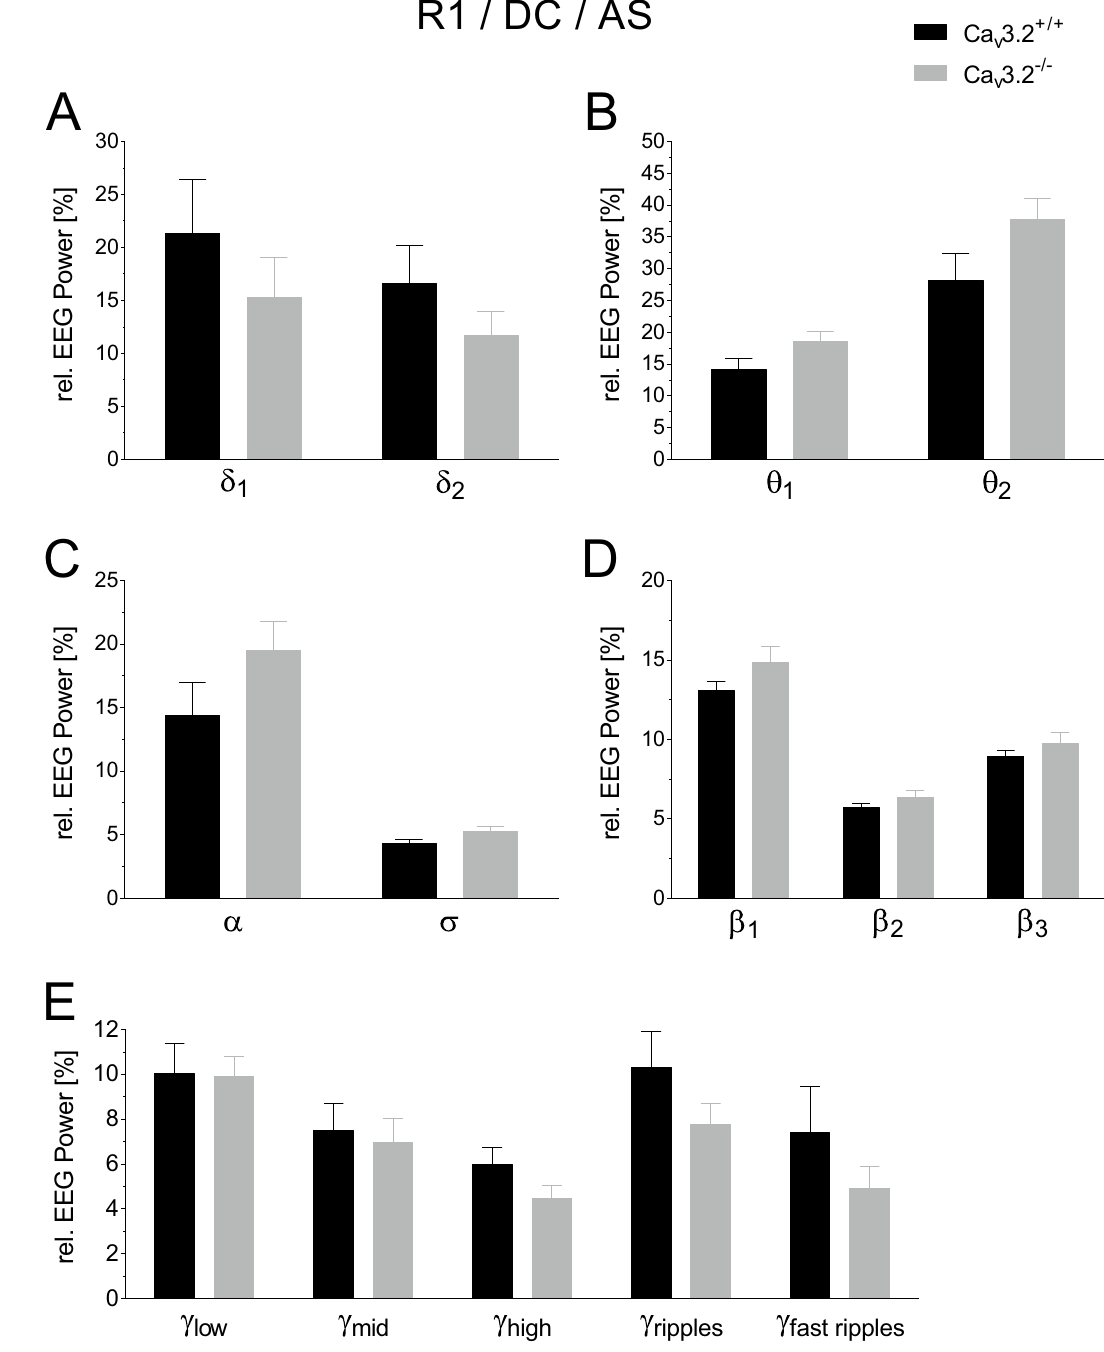
Figure 6. EEG power analysis during the active dark cycle state (24 h long-term recording R1) in Ca v 3.2 +/+ and Ca v 3.2 −/− mice. Relative EEG power (%) for the Ca v 3.2 +/+ and Ca v 3.2 −/− is displayed for the individual frequency ranges ( A – E ). No significant alterations were during R1 at the DC in the AS (Fig. 6). As for baseline recording R1, no alterations were observed for the other frequency bands (Supplementary Fig. 3). EEG power analysis of R1/R2 during the non-active state of the dark cycle. Relative EEG power analysis of the dark cycle, non-active state of R1 exhibited a significant increase in θ 2 , α and σ in Ca v 3.2 −/− mice com- pared to controls (θ 2 , 33.344 ± 3.553% (Ca v 3.2 +/+ ) vs. 42.415 ± 2.047% (Ca v 3.2 −/− ), p = 0.0441; α, 12.878 ± 1.458% (Ca v 3.2 +/+ ) vs. 17.287 ± 1.063% (Ca v 3.2 −/− ), p = 0.0284; σ, 5.762 ± 0.543% (Ca v 3.2 +/+ ) vs. 7.214 ± 0.338% (Ca v 3.2 −/− ), p = 0.0395) (Fig. 7B,C). No significant alterations were observed for δ 1 , δ 2 , θ 1 , β 1 , β 2 , β 3 , and the γ frequency bands